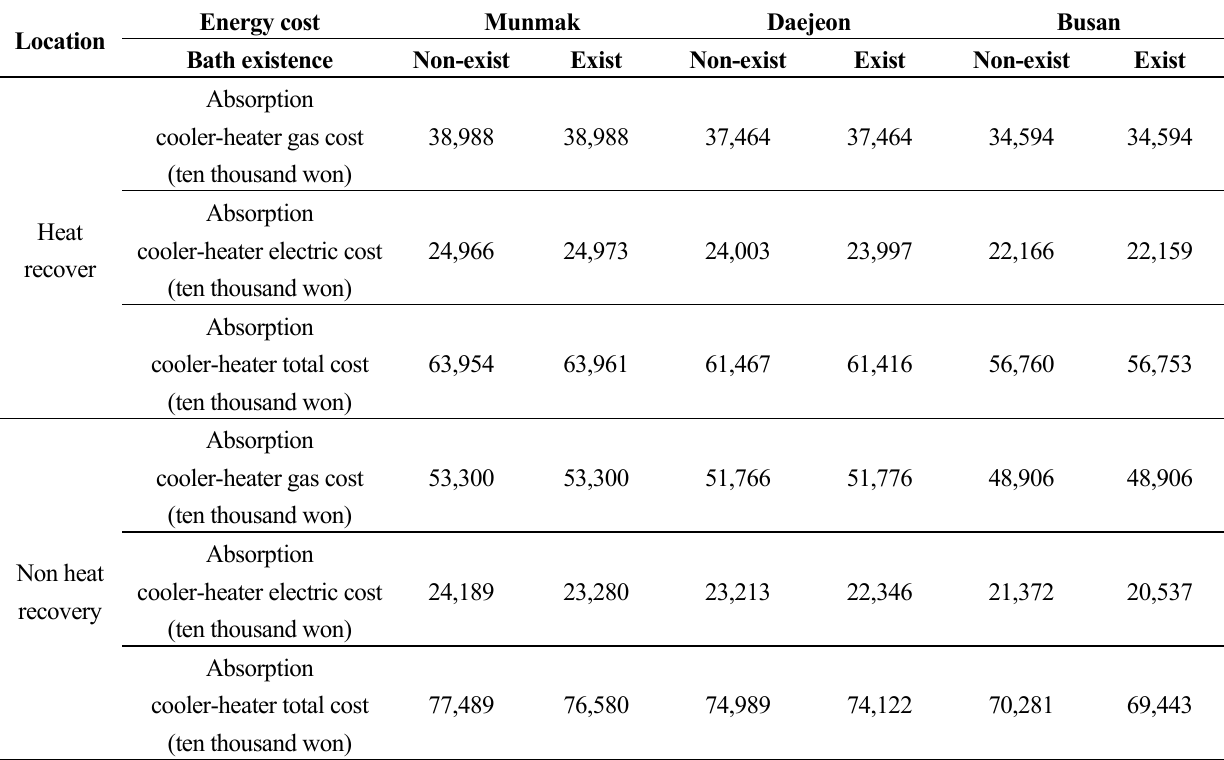
Table 6. Energy cost of gas absorption cooler-heater system for a resort building (total floor area = 33,000 m 2 ). Exist Non-exist Exist